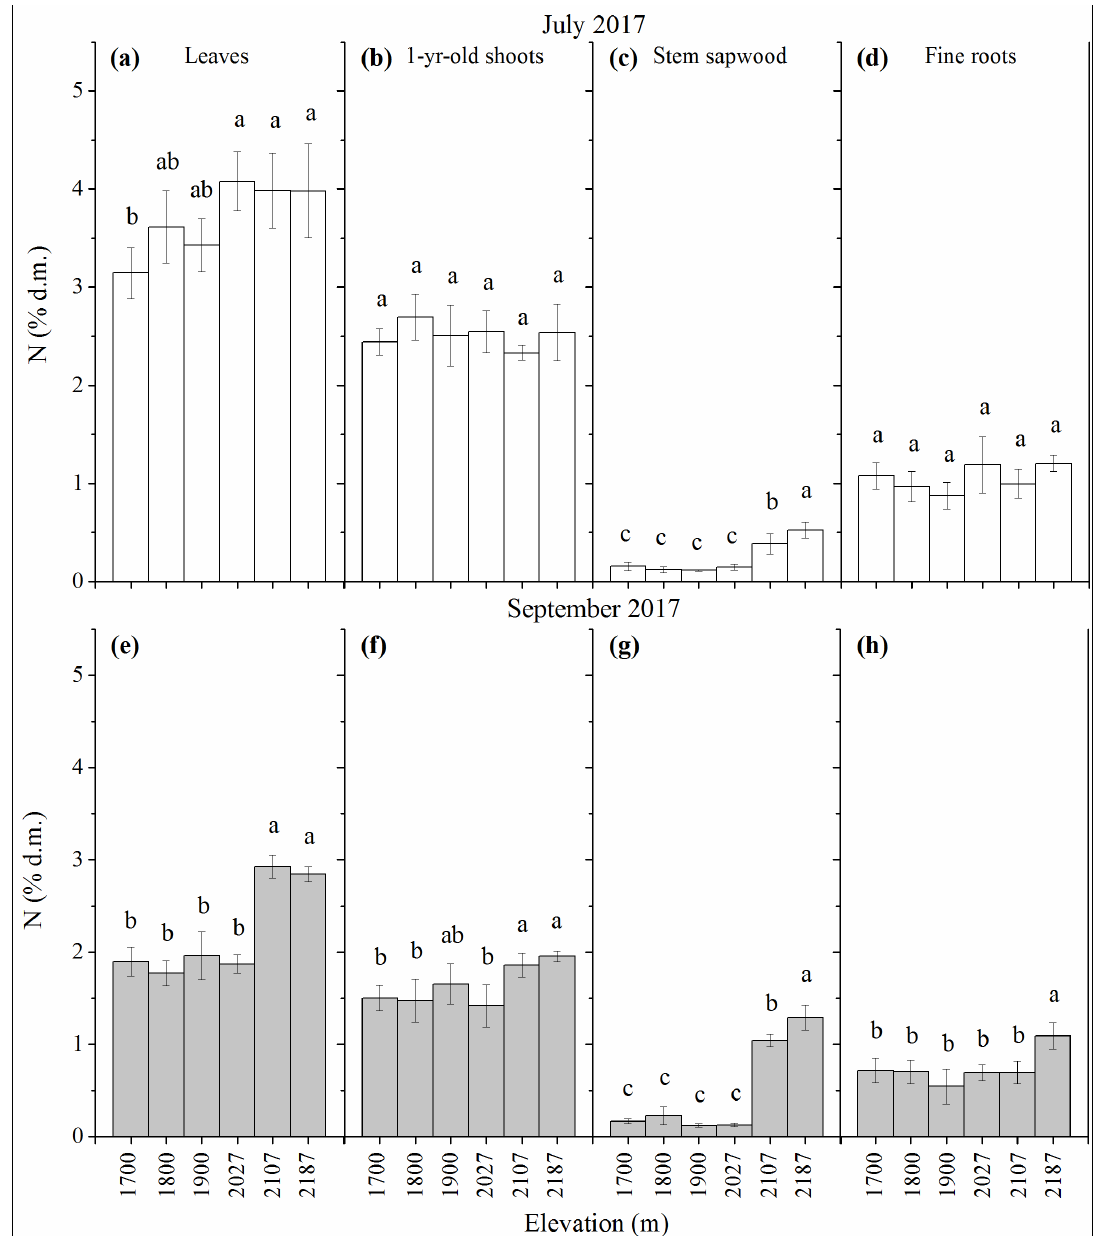
Figure 2. Seasonal tissues concentration (Mean ± 1SD; % of dry matter) changes in total nitrogen (N) of Betula ermanii trees along elevational gradients in Changbai Mountain ( n = 5 for each elevational site and tissue type). Different letters display significant differences at the 0.05 level among elevations as determined by Tukey’s HSD test.